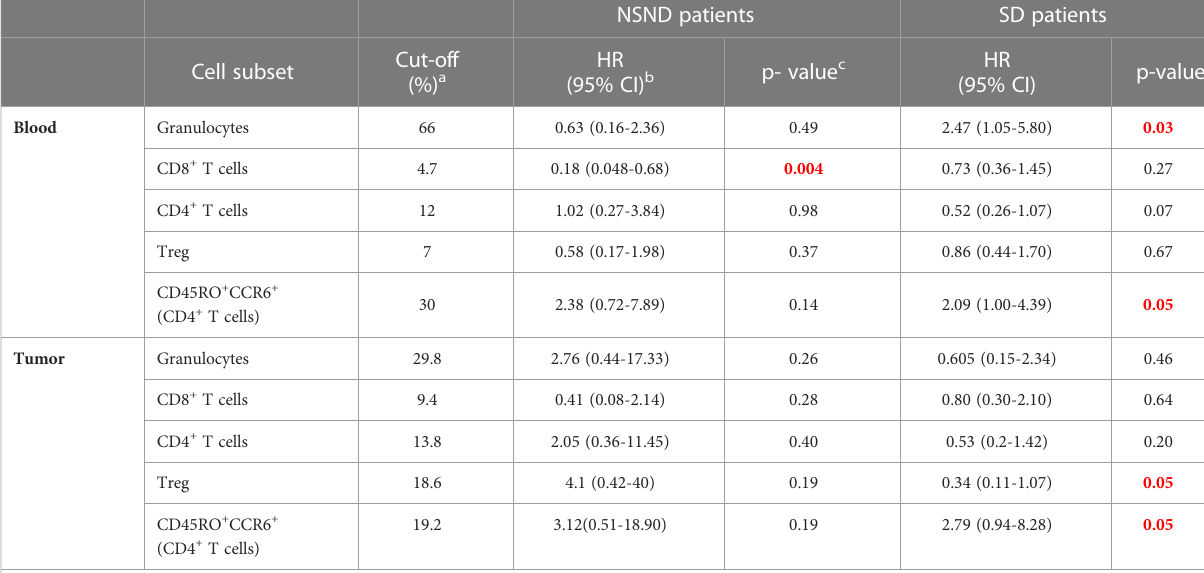
TABLE 2 Univariate COX regression analysis of immune cells in OSCC patients.